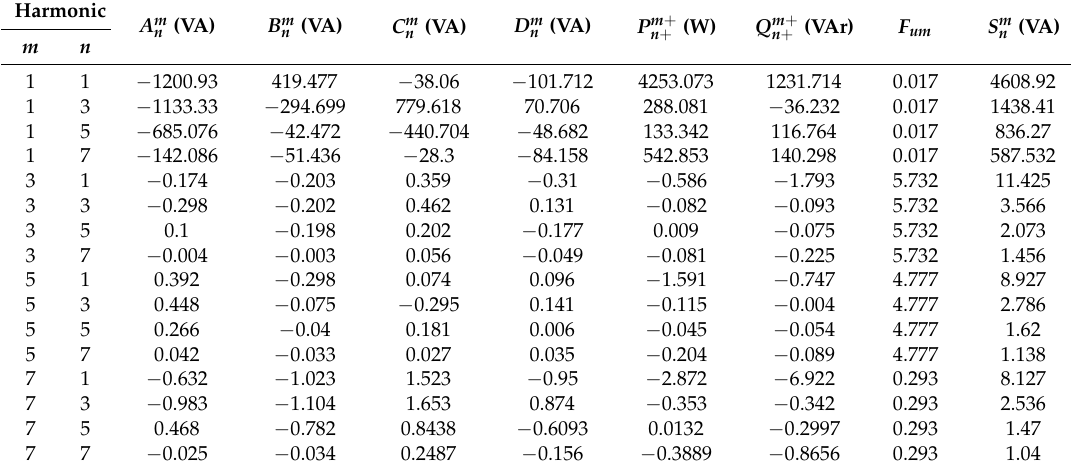
Table 8. Results in load